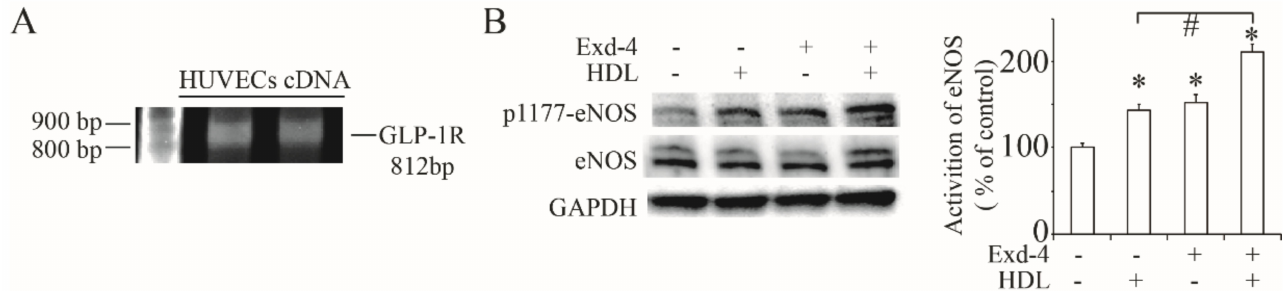
Figure 1. Activation of eNOS by exendin-4 in HUVECs . ( A ) Full-length GLP-1 receptor transcript expression as analysed by RT-PCR in HUVECs. ( B ) Phosphorylation of eNOS at Ser1177 stie stimu- lated by the treatment of exendin-4 at 10 nM for 24 h, pre-treating with or without HDL at 50 ng/mL for 10 min. The ratio of p1177-eNOS to eNOS is shown as percent of control. A graph showing the mean ± SEM (n = 3) of separate experiments for each treatment group is included. * p < 0.05 compared with control; # p < 0.05 compared with HDL treatment.